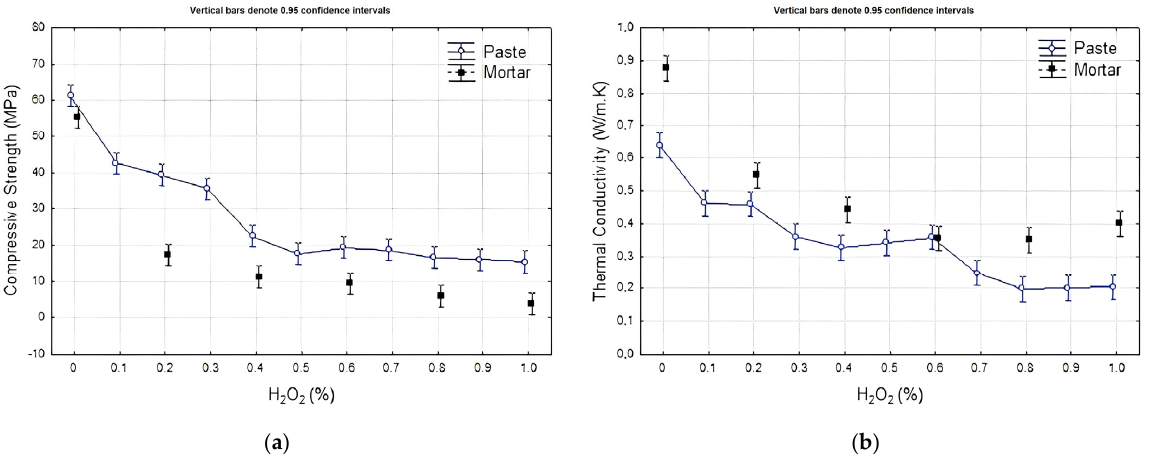
Figure 3. E ff ect of H 2 O 2 concentration on the compressive strength ( a ) and thermal conductivity ( b ) of geopolymers pastes and mortars.